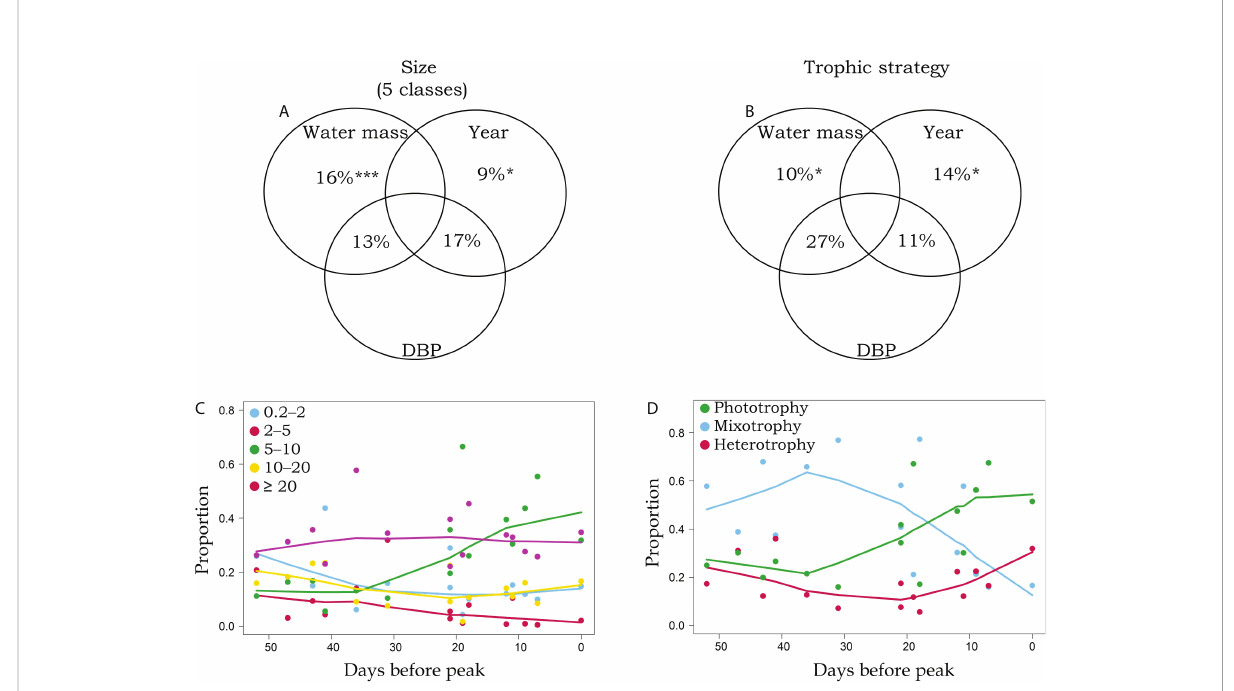
FIGURE 3 Venn diagrams representing the variation partitioning of size classes (A) and trophic strategy (B) across water masses, years, and the number of days before peak (DBP) chlorophyll. The smoothed (LOWESS function, stats core R package, 60% span) relationship between the proportion of size classes (C) and trophic strategies (D) and the number of DBP. *and *** represent partial RDA p-values of ≤ 0.05 and ≤ 0.001, respectively.